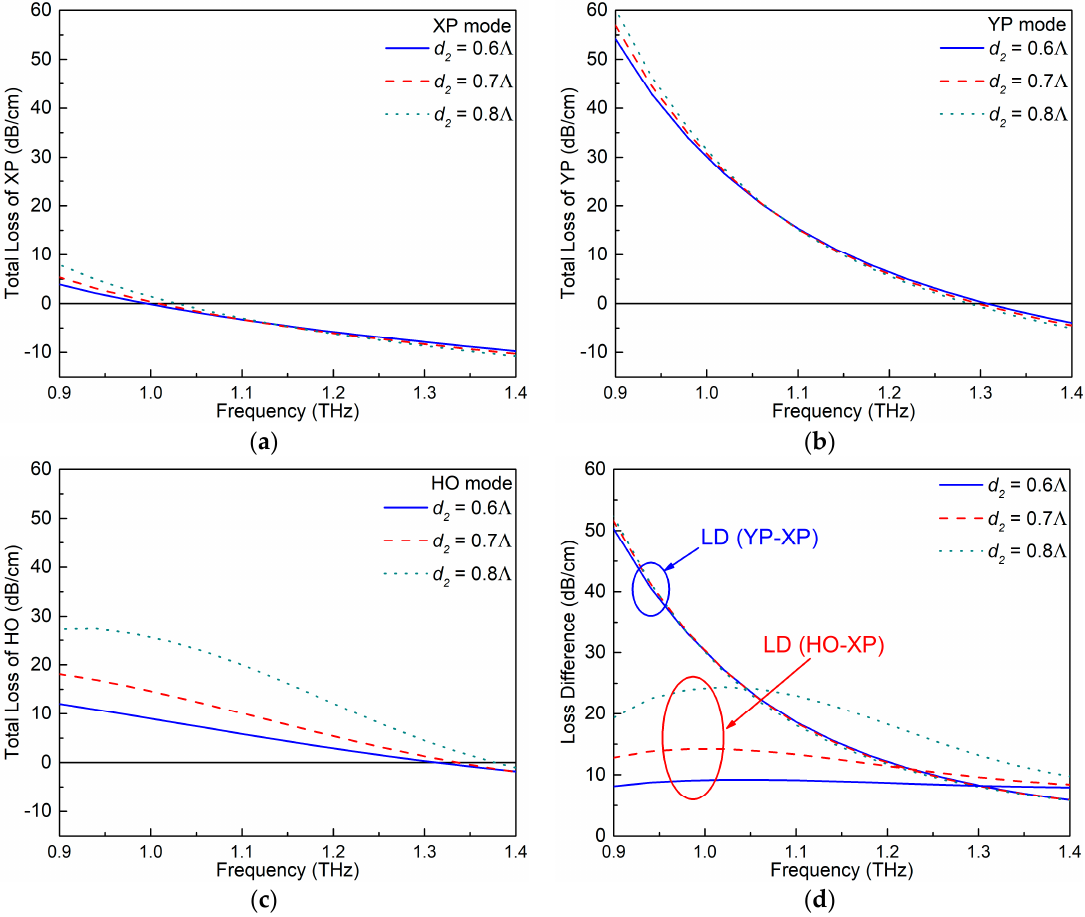
Figure 7. The TL values of the ( a ) XP, ( b ) YP, and ( c ) HO modes of the active ENZ-based PCF as functions of the frequency for different diameter d 2 . ( d ) The corresponding LD values between the wanted and unwanted modes.